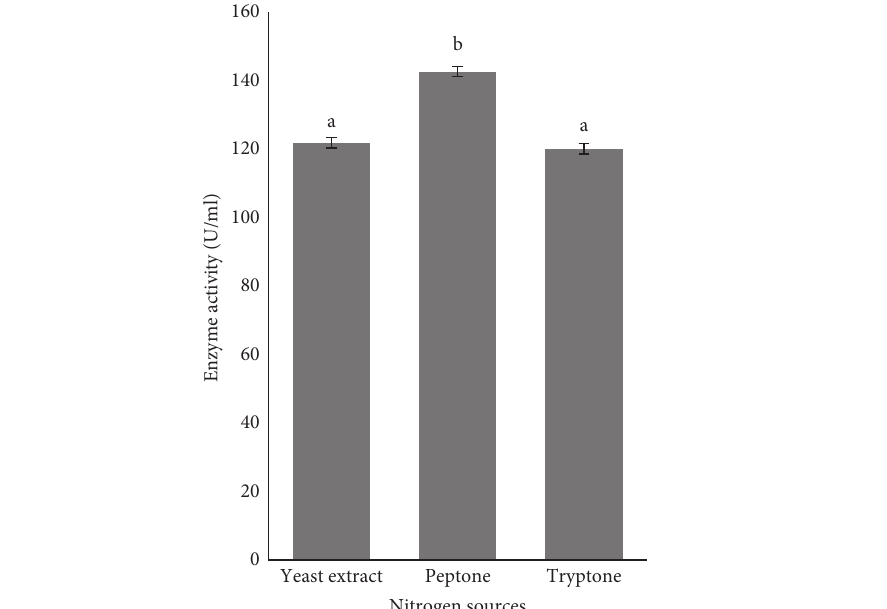
Figure 4: Effect of nitrogen sources on dextranase production from Talaromyces sp. at the second day of fermentation. Symbols (mean ± SE, n � 6) having similar letters are not significantly different from each other (Bonferroni test, P < 0 . 017).